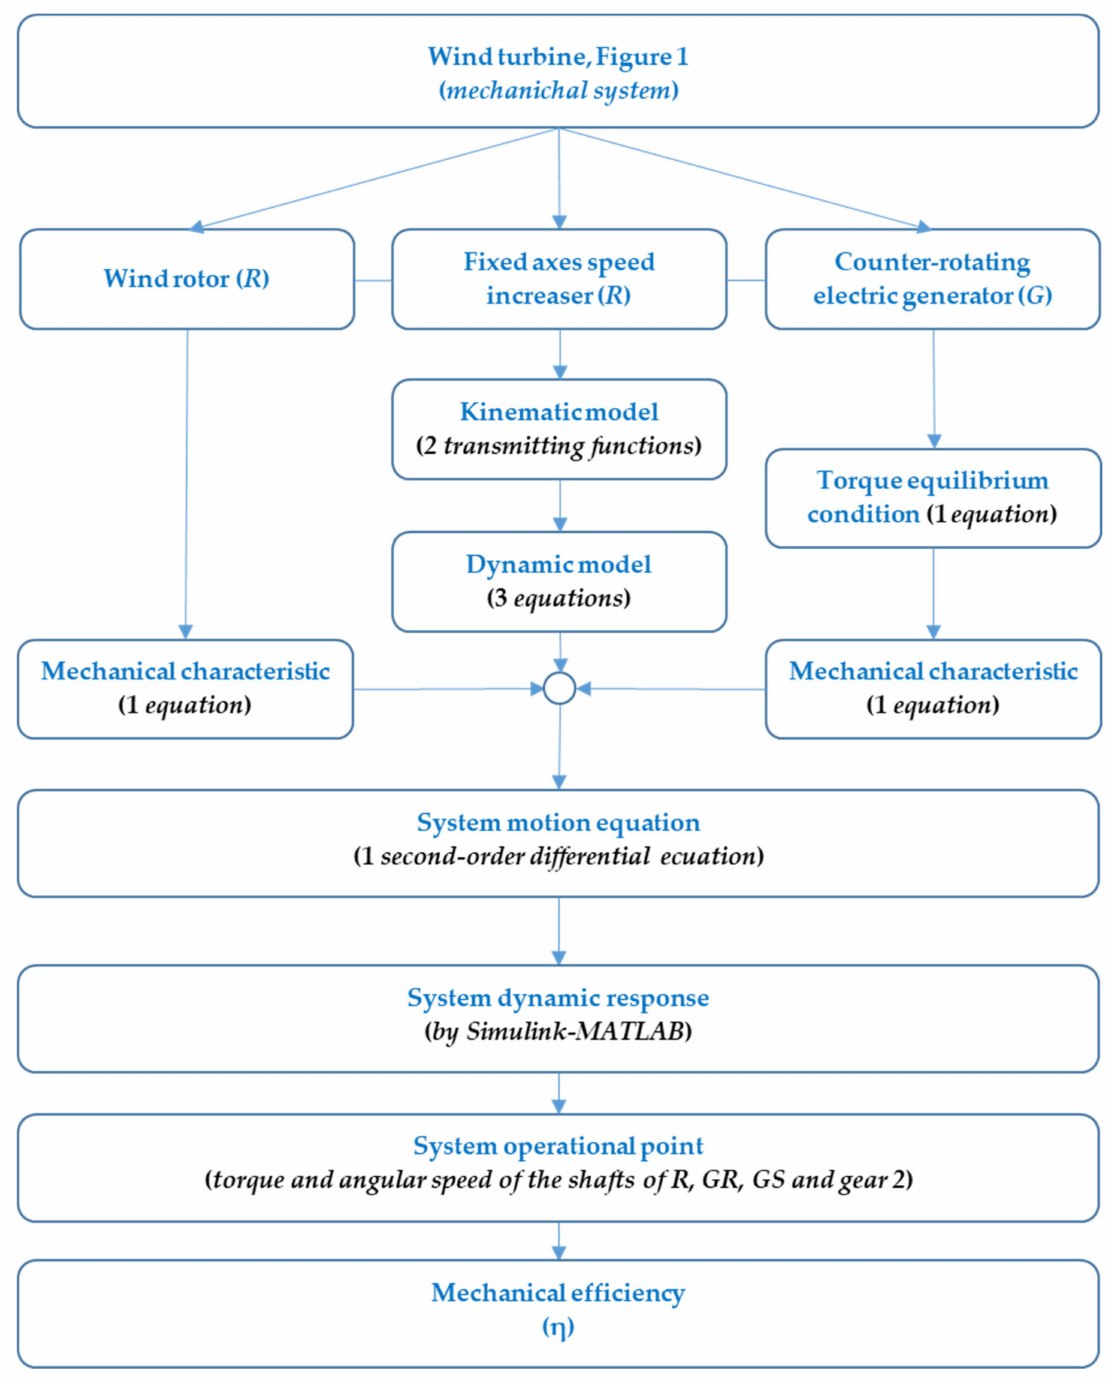
Figure 2. Flowchart of the proposed dynamic modelling for single-rotor wind turbines with counter-rotating electric